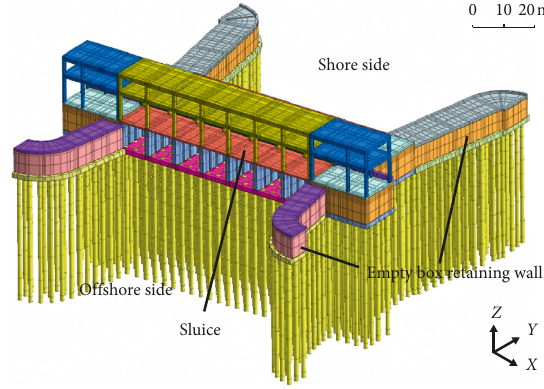
Figure 14: Sluice and its lower piles model.